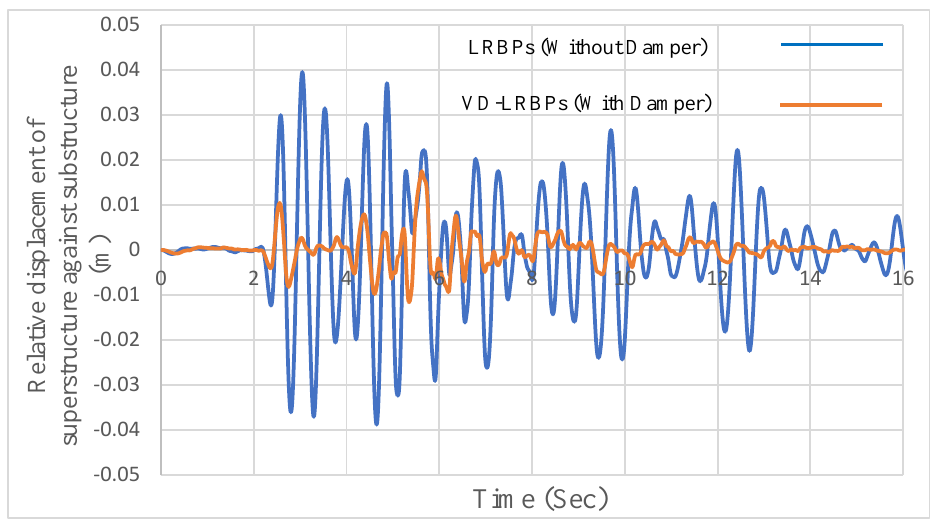
Figure 20. The relative displacement of superstructure versus substructure histories under Tabas earthquake.